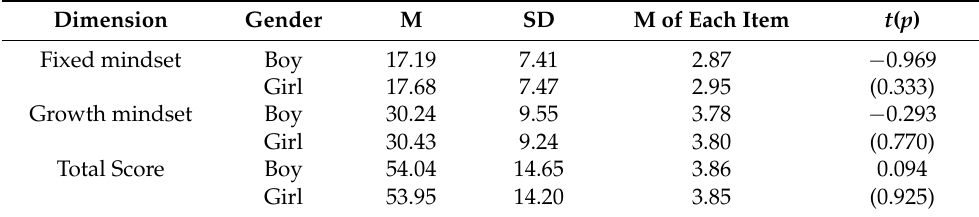
Table 5. The difference of cognitive mindset by gender.